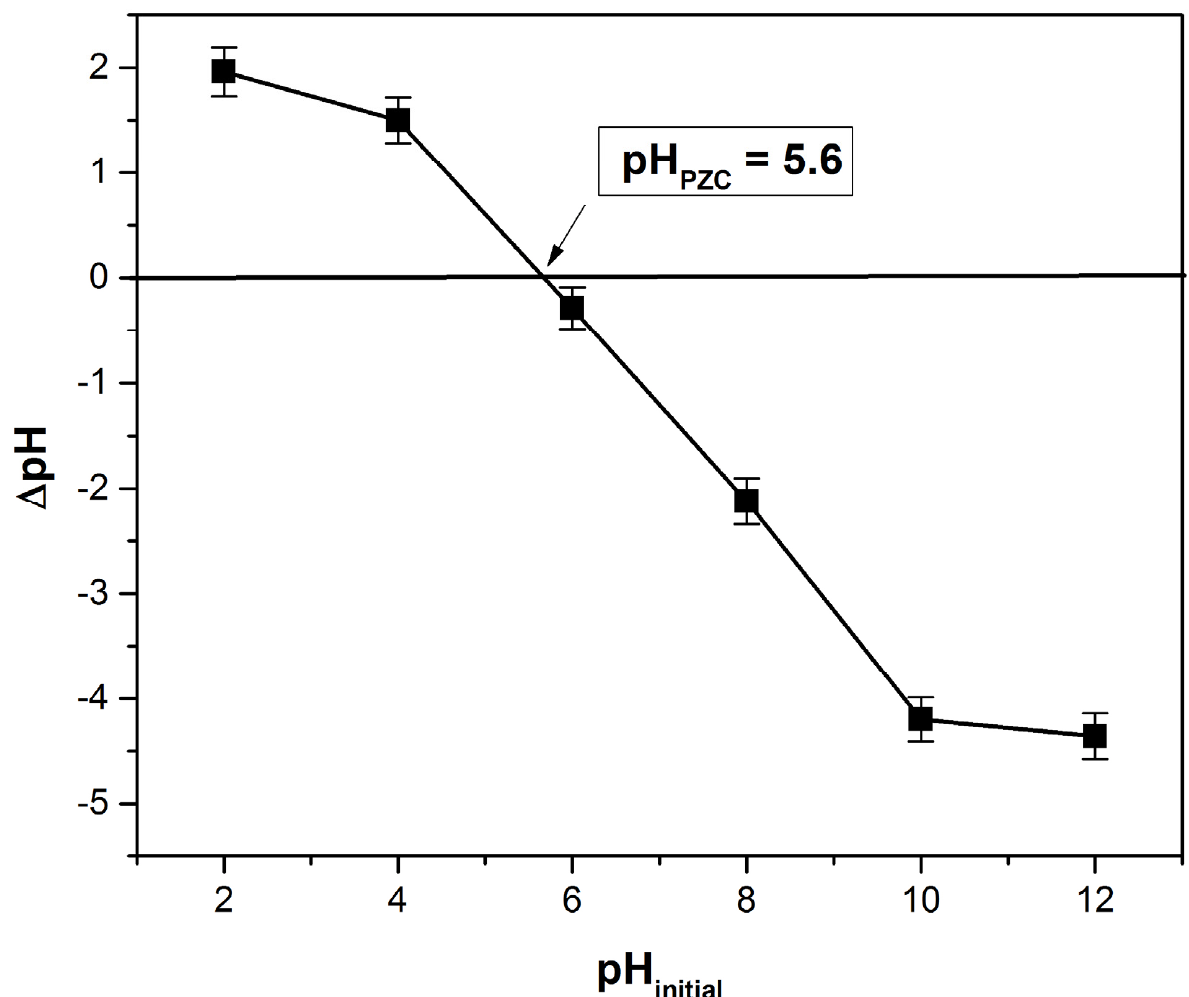
Figure 4. Determination of point of zero charge using the solid addition method.